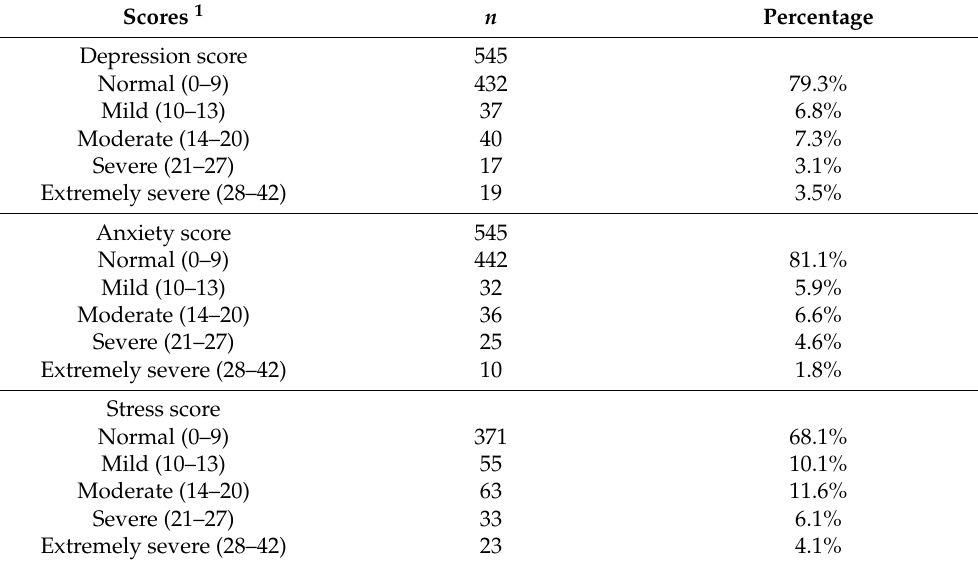
Table 2. Prevalence of self-reported depression, anxiety, and stress by